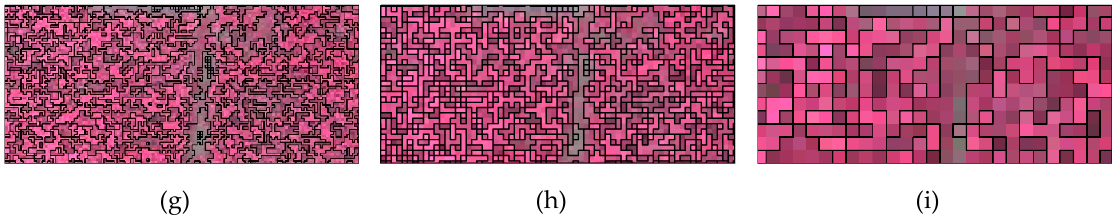
Figure 3. Local representation of secondary segmentation for multi-scale images: ( a ) 0.025 m (segmentation scale: 2500); ( b ) 0.05 m (segmentation scale: 1000); ( c ) 0.1 m (segmentation scale: 100); ( d ) 0.25 m (segmentation scale: 25); ( e ) 0.25 m (segmentation scale: 50); ( f ) 0.25 m (segmentation scale: 100); ( g ) 0.5 m (segmentation scale: 50); ( h ) 1 m (segmentation scale: 25); ( i ) 2.5 m (segmentation scale: 25).